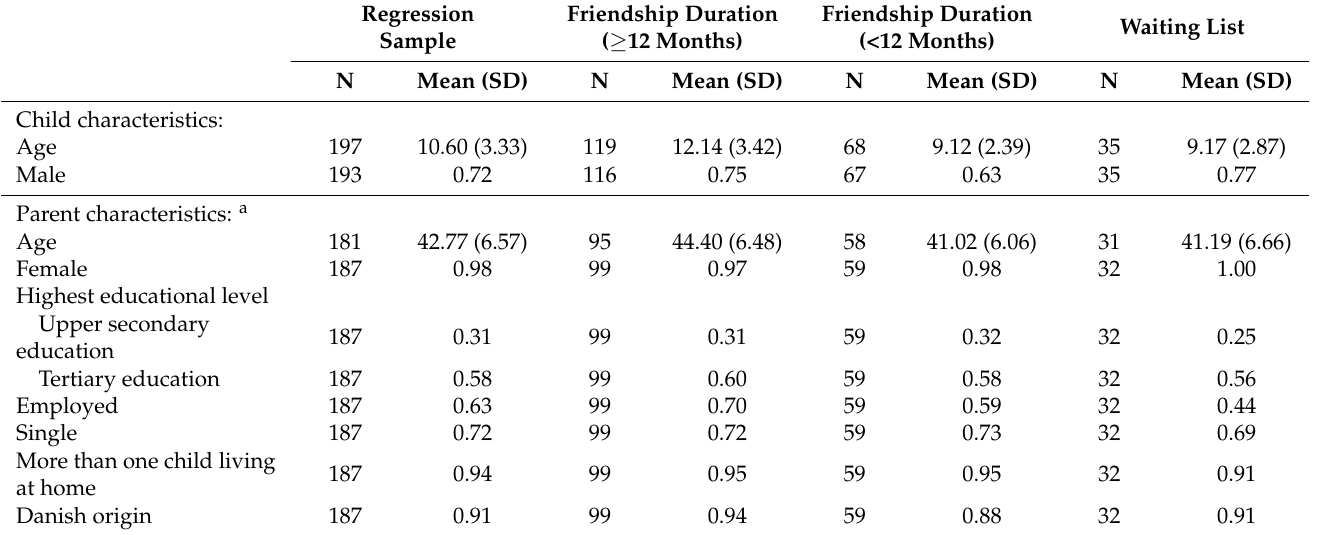
Table 1. Summary Statistics of Individual Demographic and Socioeconomic Background